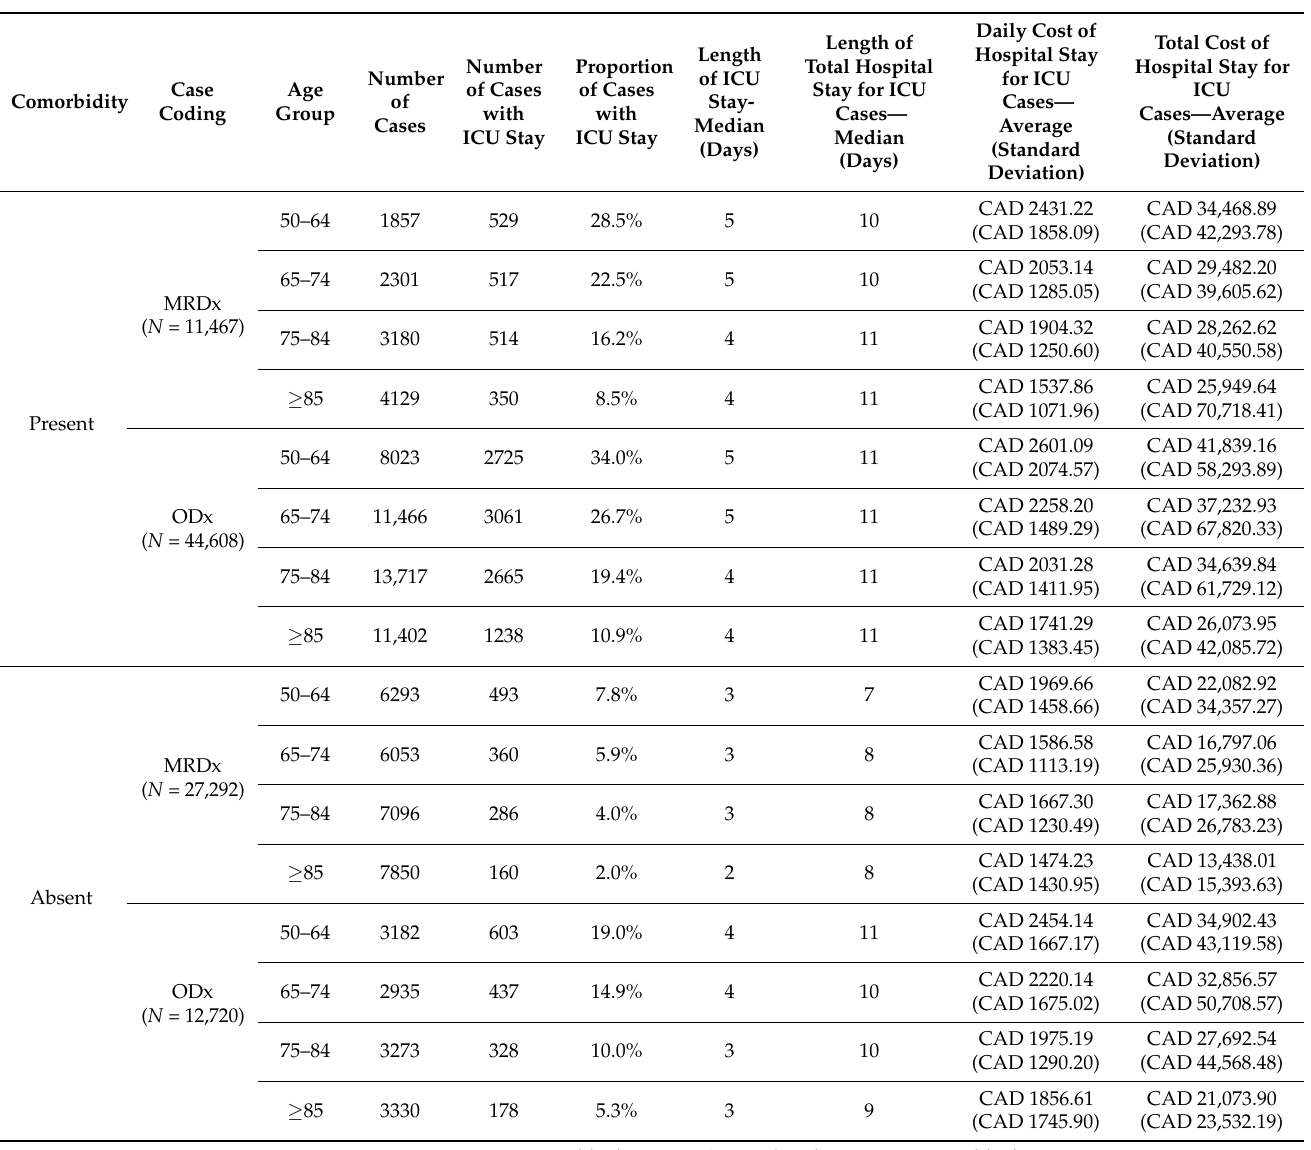
Table 2. Intensive care unit length of stay and total cost of hospitalization for all-cause community- acquired pneumonia, by comorbidity, case coding, and age group, in fiscal year 2018–2019, Canada (excluding